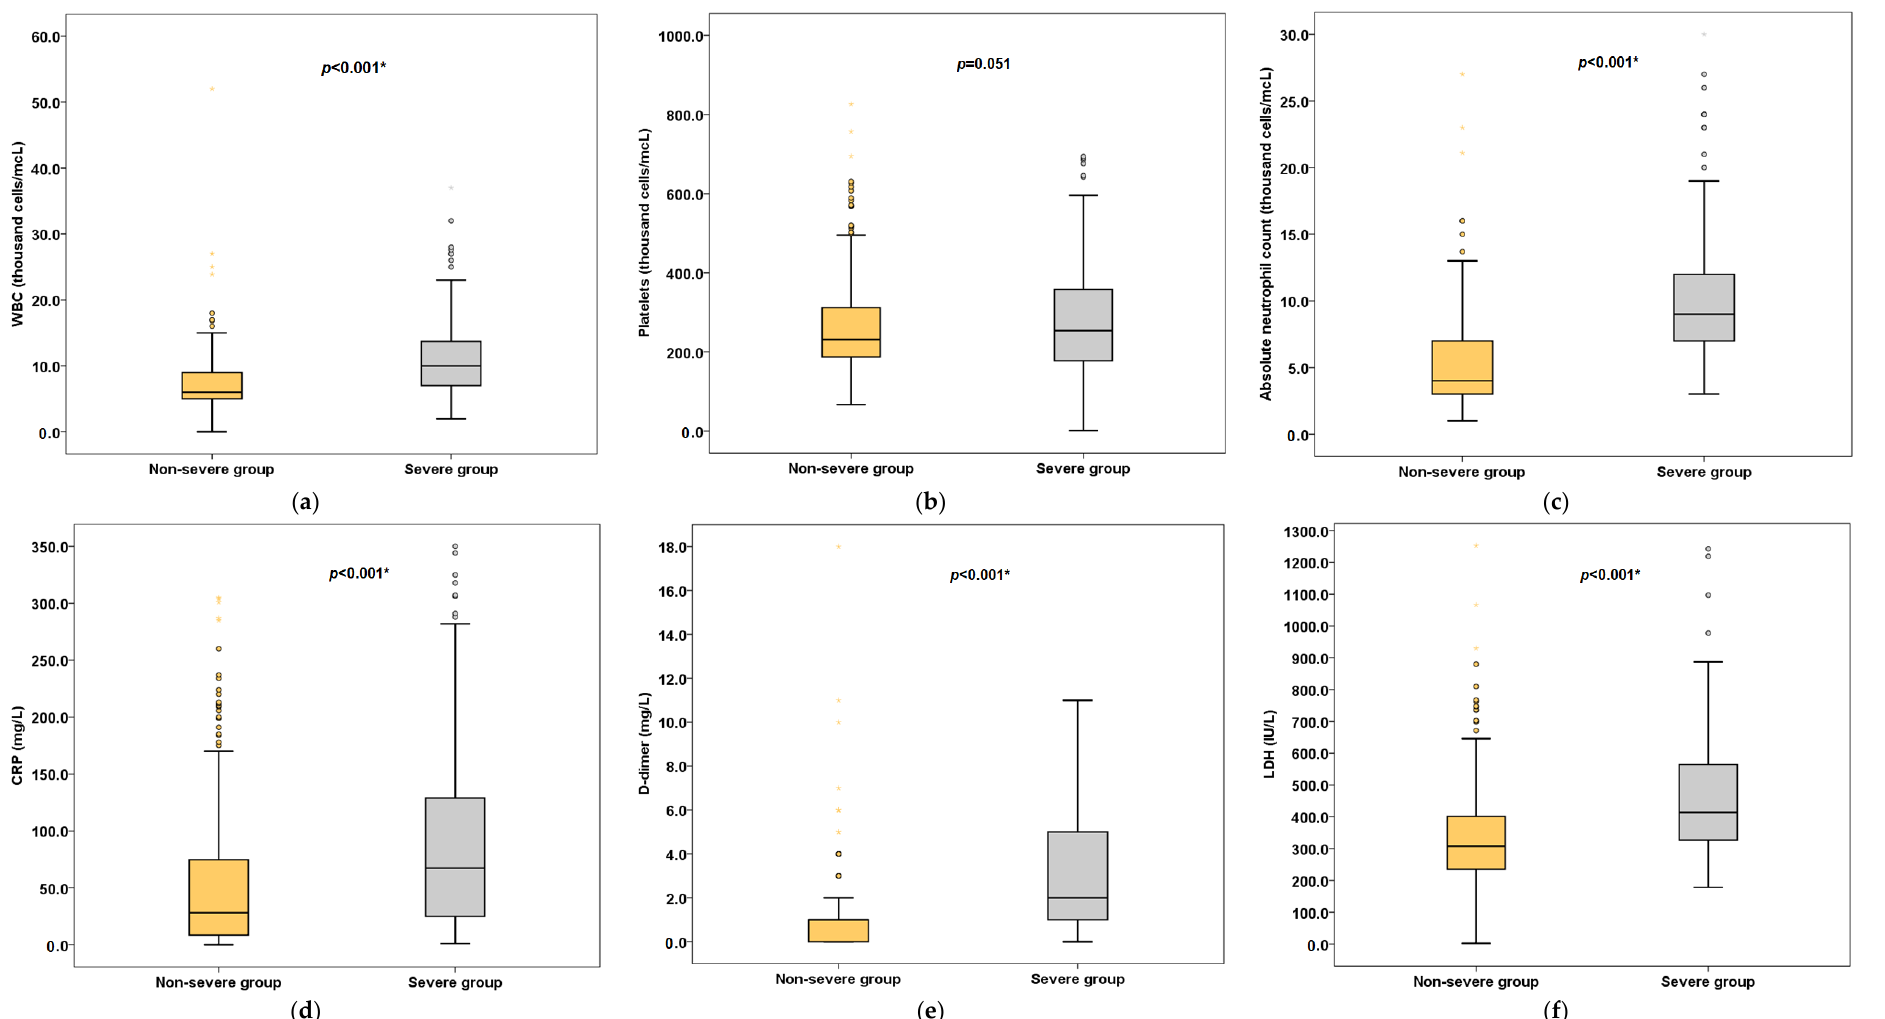
Figure 1. Laboratory results (selected) stratified by severity of disease. Box plots represent ( a ) WBC, ( b ) Platelets, ( c ) Neutrophils, ( d ) CRP, ( e ) D-dimer, ( f ) LDH. * Statistically significant.